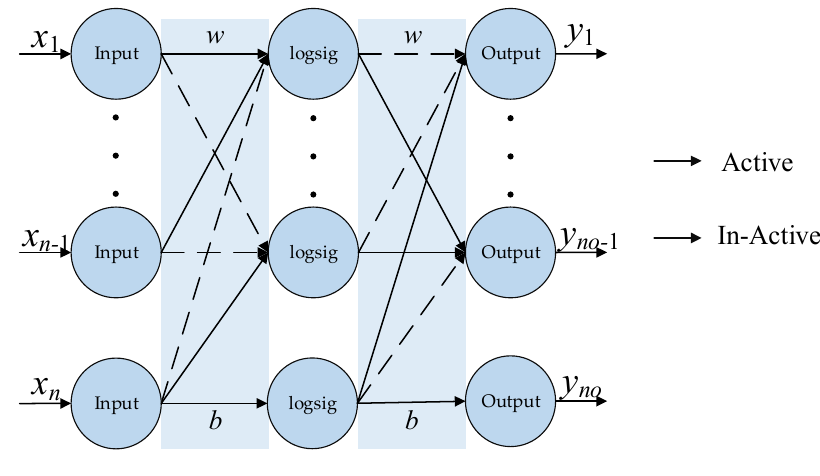
Figure 6. The structure of the proposed l 1 -BPNN.